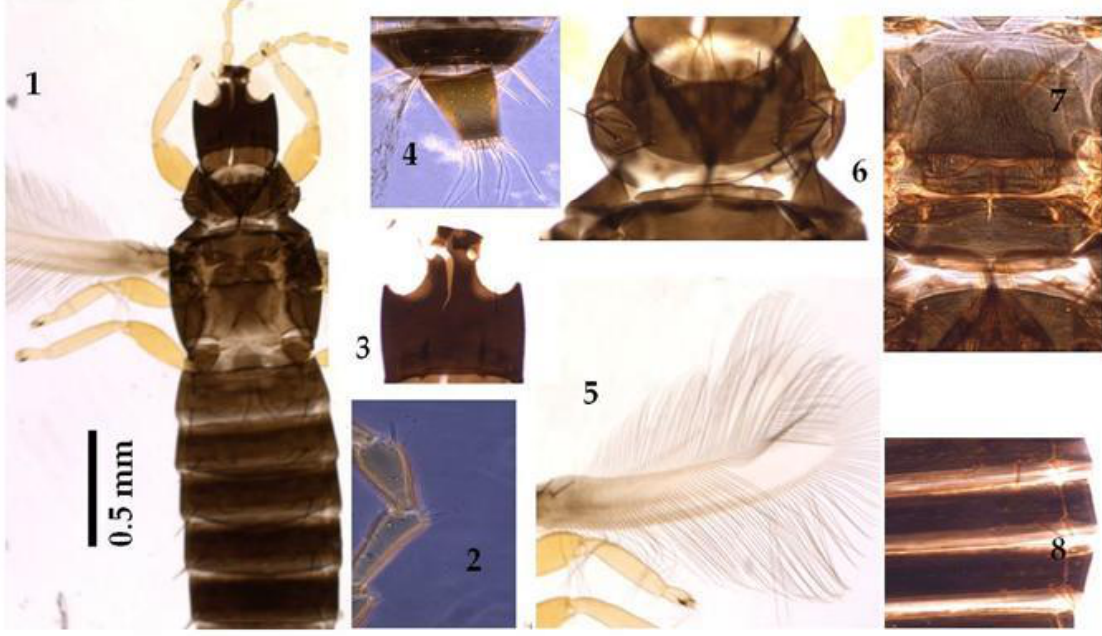
Figure 2. 1, Liothrips leucopus : 2, antennal segments III–IV; 3, head; 4, segments IX–X; 5, wing pronotum; 6, pronotum; 7, mesonotum and metanotum; 8, abdominal tergites. Table 1. The different species of thrips recorded on olive trees in the province of Batna (2019 – 2021). Suborder Family Species Feed